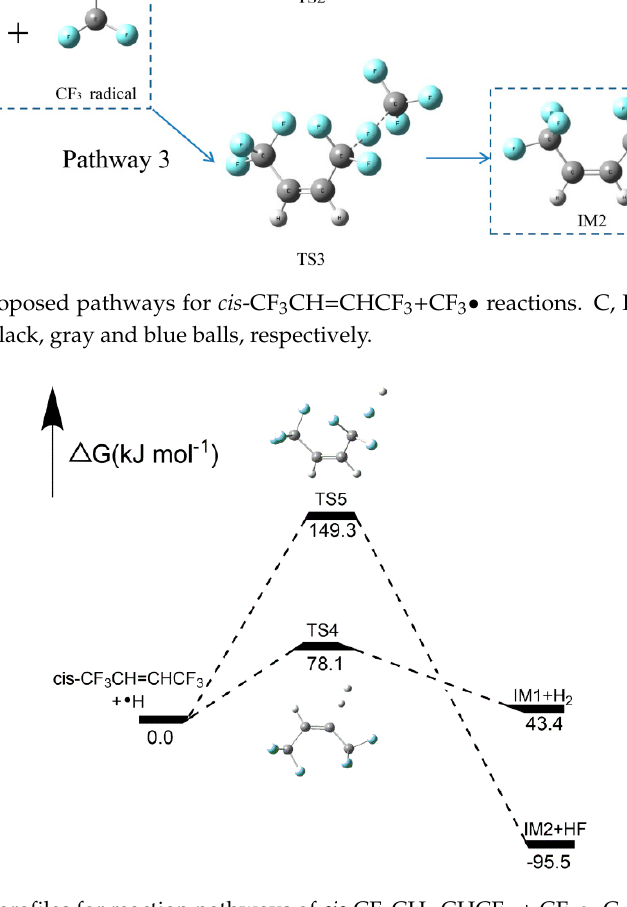
Figure 14. Energy profiles for reaction pathways of cis -CF 3 CH = CHCF 3 + CF 3 • . C, H and F atoms are represented with black, gray and blue balls, respectively.